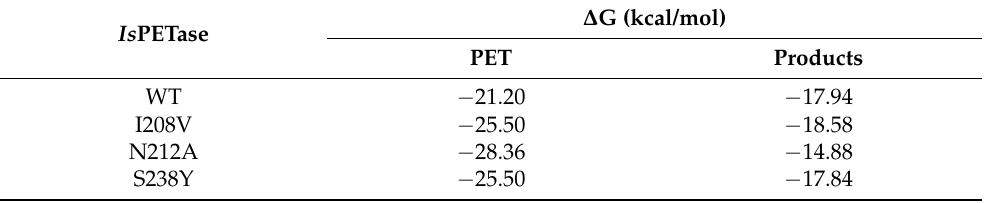
Table 3. Binding free energy calculations of substrate and products in complex with Is PETase. Is